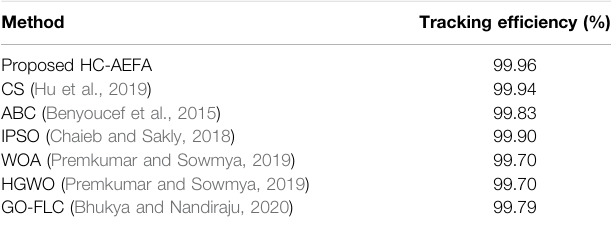
TABLE 6 | Comparison of tracking ef fi ciency for HC-AEFA in MPPT solution and previous studies.